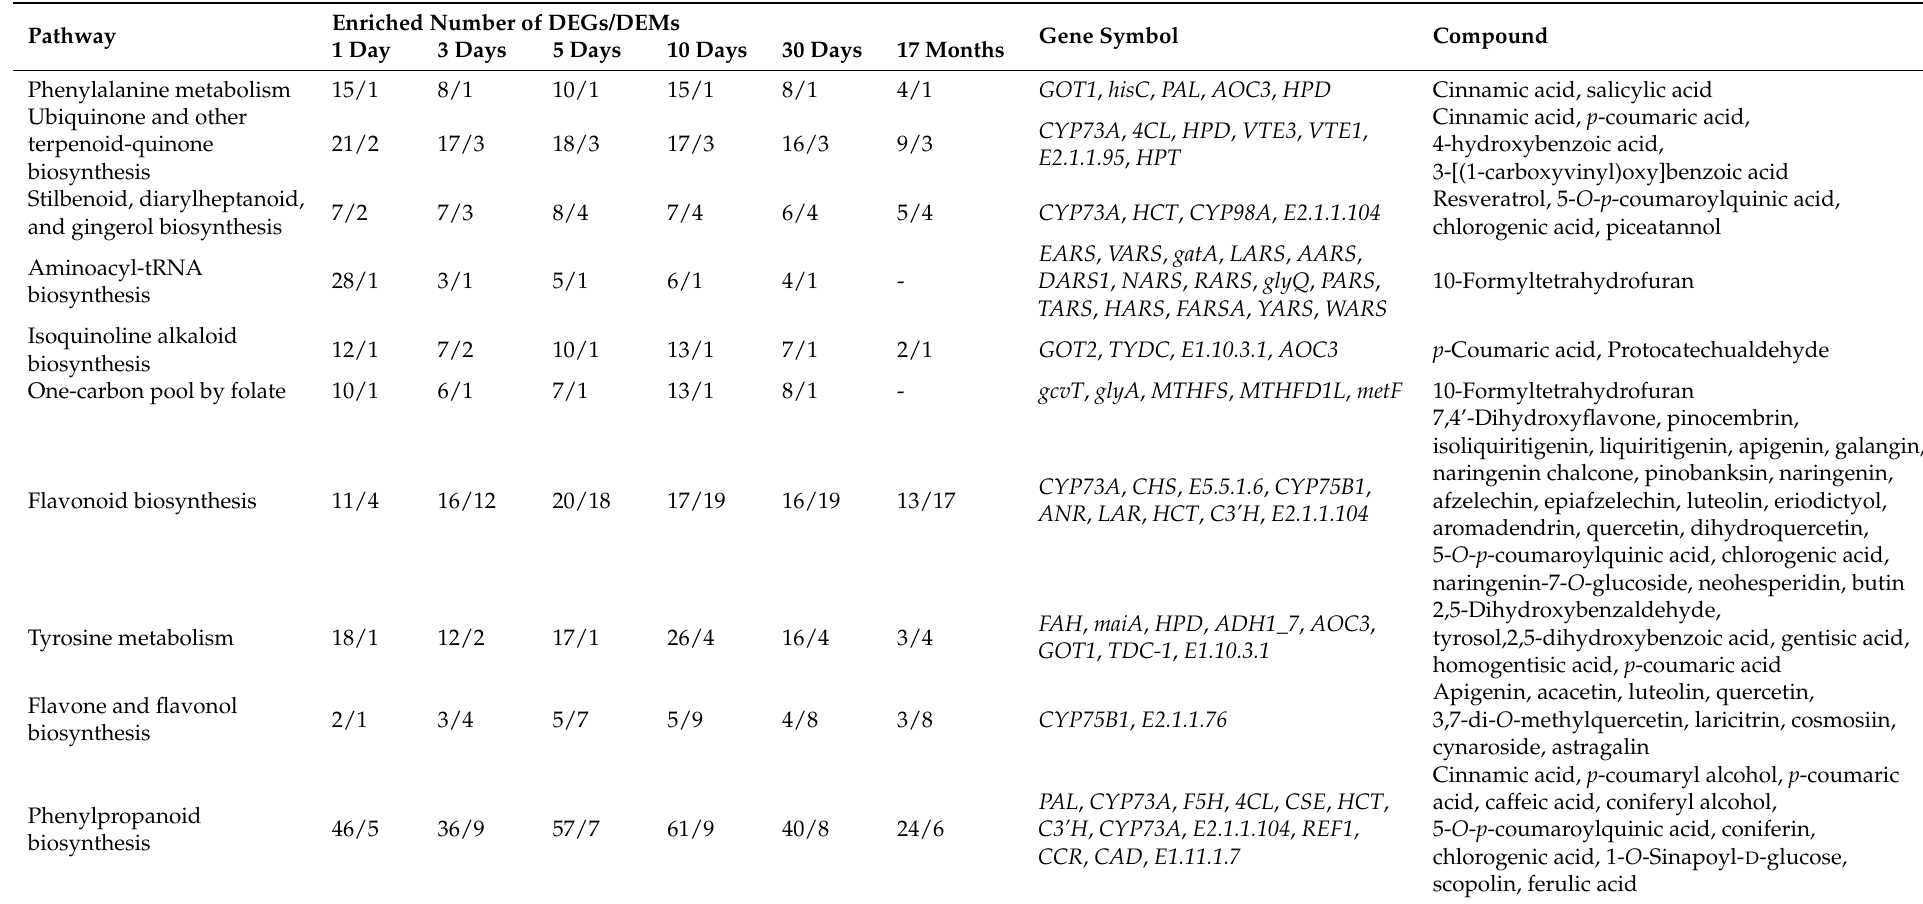
Table 1. Enriched KEGG pathways according to co-analysis of DEGs and